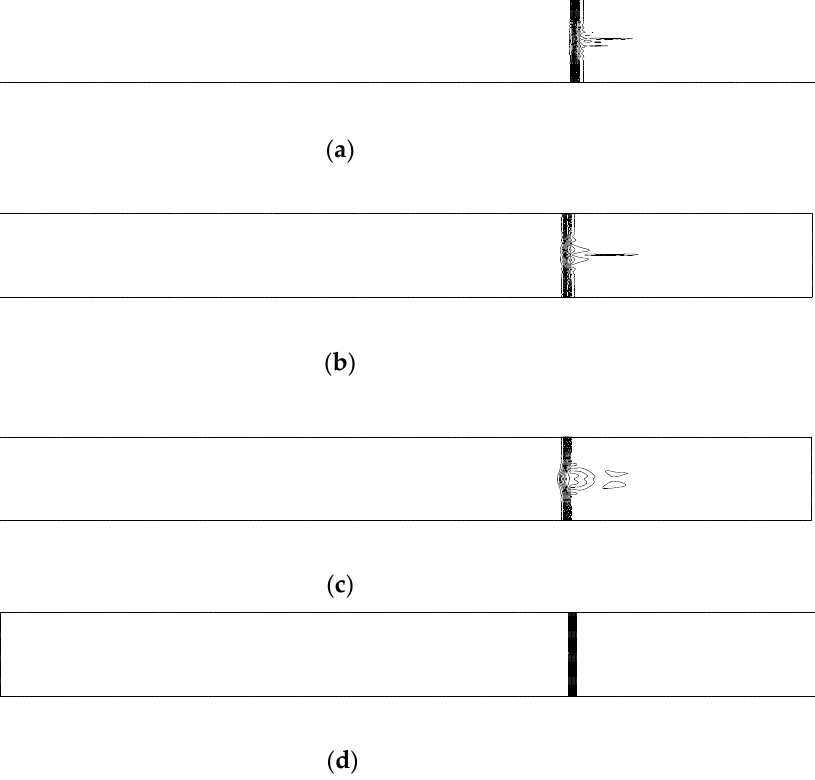
( a ) ( b ) ( c ) ( d ) Figure 17. Density contours of the odd – even grid perturbation problem ( M s = 6.0, second order MUSCL reconstruction with the minmod limiter, 1 x  = ); ( a ) AUSM+; ( b ) AUSMPW+; ( c ) SLAU; ( d ) AUSMAS. 8. Conclusions Remarks In this paper, a new AUSM-type scheme called AUSMAS is proposed. Theoretical analyses are conducted in Sections 4 – 6 and they indicated that the AUSMAS scheme has the following two advantages, independent of any tuning coefficient: (a) for low speeds, it gains a high level of accuracy when the Mach number approaches to 0, (b) for high speeds, it is robust against the shock anomaly and free from the appearance of the un- physical expansion shocks. Two one-dimensional test cases (Sections 7.1 and 7.2) show that AUSMAS is able to capture the shocks and contact discontinuities as sharply as other schemes including SLAU, AUSM+ and AUSMPW+. Moreover, it is free from the appear- ance of the unphysical expansion shocks in supersonic/hypersonic flow simulations. In Section 7.3, AUSMAS displays its high resolution at low speeds. Quirk’s test in Section 7.4